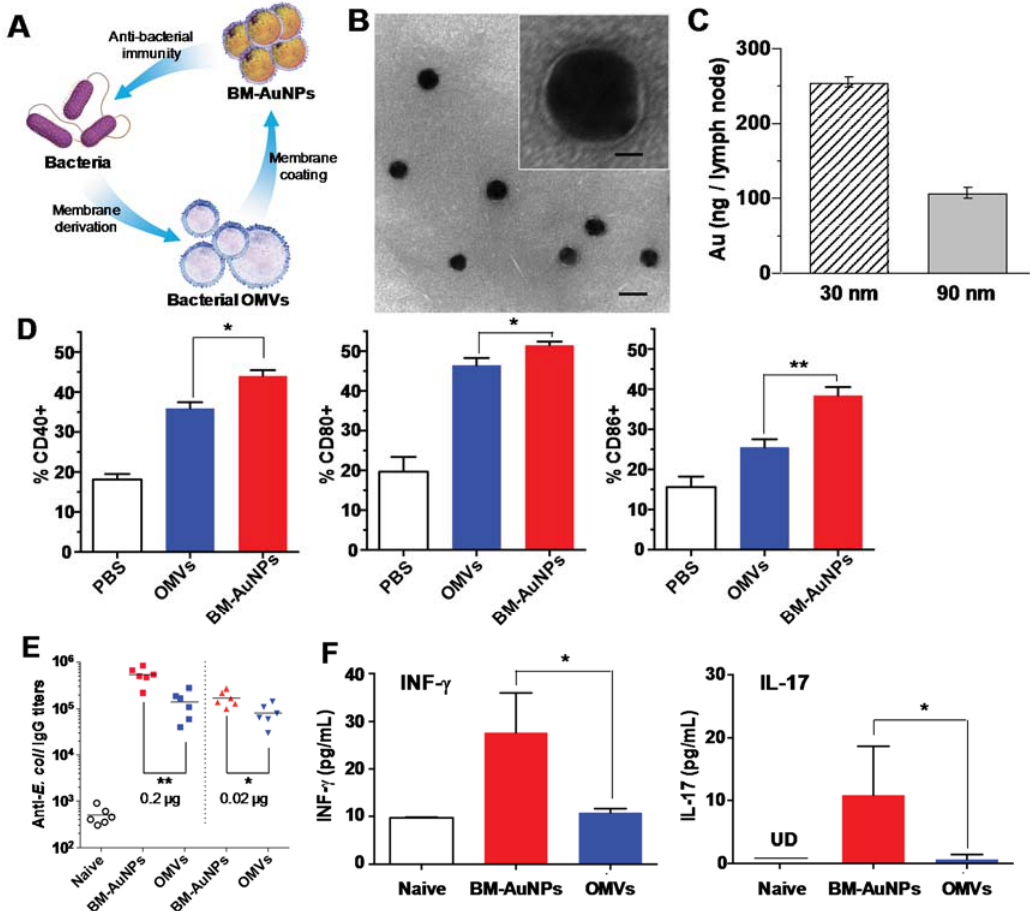
Figure 3. ( A ) A schematic illustration of modulating antibacterial immunity via bacterial membrane-coated nanoparticles. Briefly, bacterial membrane is collected from source bacteria in the form of secreted outer membrane vesicles (OMVs) and then coated onto citrate-stabilized gold nanoparticles (AuNPs) to form bacterial membrane-coated AuNPs (BM-AuNPs). When injected subcutaneously into mice, BM-AuNPs elicit bacterium-specific immunity against the source bacteria; ( B ) A representative TEM image showing the spherical core-shell structure of the BM-AuNPs negatively stained with uranyl acetate (scale bar, 50 nm). Inset: a zoomed-in view of a single BM-AuNP (scale bar, 10 nm); ( C ) Effect of BM-AuNP size on its lymph node transport. Mice were injected with 2.5 (cid:3)g (50 (cid:3)g/mL) BM-AuNPs of 30 nm and 90 nm, respectively, via the tail base. After 24 h, the lumbar and sacral lymph nodes were collected. Gold concentration was quantified by using inductively coupled plasma mass spectrometry (ICP - MS); ( D ) Quantification of the percentage of CD11c+ DCs based on flow cytometry analysis of surface maturation markers (CD40, CD80, and CD86) on CD11c+ DCs from lumbar and sacral lymph nodes of the mice ( n = 5); ( E ) BM-AuNPs eliciting strong anti- E. coli IgG titres in vivo on day 21 ( n = 6); ( F ) BM-AuNPs inducing pronounced bacterium-specific T cell activation in vivo . The mice ( n = 10) were immunized with 0.2-(cid:3)g antigen/dose BM-AuNPs or OMVs. On day 21, splenic cells were collected and stimulated with E. coli bacteria. After 72 h of co-culturing with the bacteria, the levels of IFN-(cid:4) and IL-17 in the medium were quantified using an ELISA. Reproduced with permission from Reference